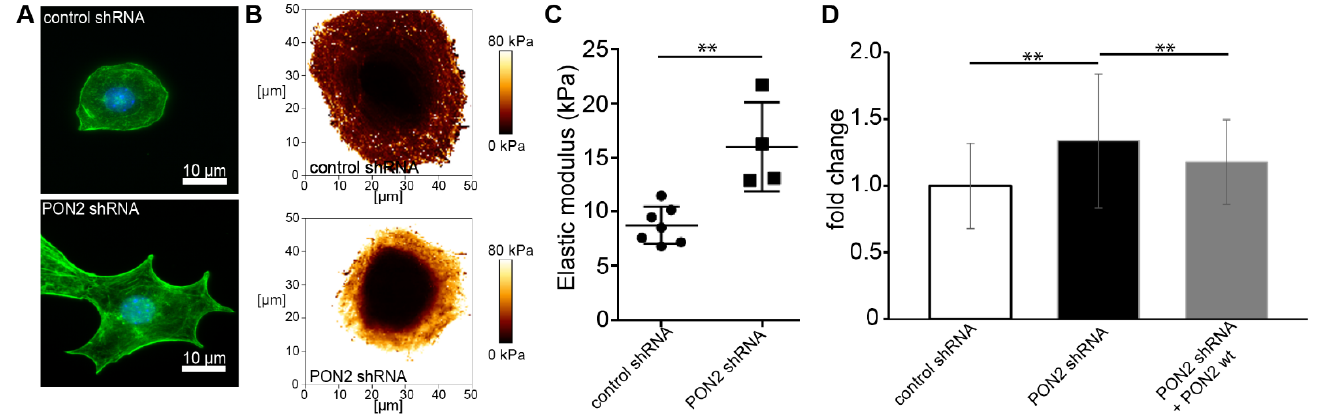
Figure 1. PON2 deficiency causes cytoskeletal rearrangement and increased cortical stiffness in podocytes. Phalloidin staining of stable podocyte cell lines expressing shPON2 or control shRNA ( A ). shPON2-expressing podocytes appear with pointed cell boundaries and pronounced cortical actin. Representative images of Young’s Modulus maps of PON2-proficient and PON2-deficient podocytes ( B ). Loss of PON2 results in increased cortical stiffness as compared to control (mean 15.99 vs. 8.75 kPa; p = 0.023; CI 95%: 3.327–11.14) ( C ). Force curves of podocytes expressing control shRNA (31 cells), PON2 shRNA (51 cells), or PON2 shRNA + PON2 wt (15 cells) of at least four independent experiments were analyzed for cortical stiffness relative to control shRNA. y -axis shows fold change of cortical stiffness compared to control shRNA expressing mouse podocytes. Cortical stiffness is increased in PON2-deficient podocytes (1.34-fold, SD 0.50 PON2 shRNA; ** p < 0.01). Increased cortical stiffness is reduced after stable re-expression of PON2 (1.17-fold, SD 0.32 PON2 shRNA + PON2 wt; ** p < 0.01) ( D ).